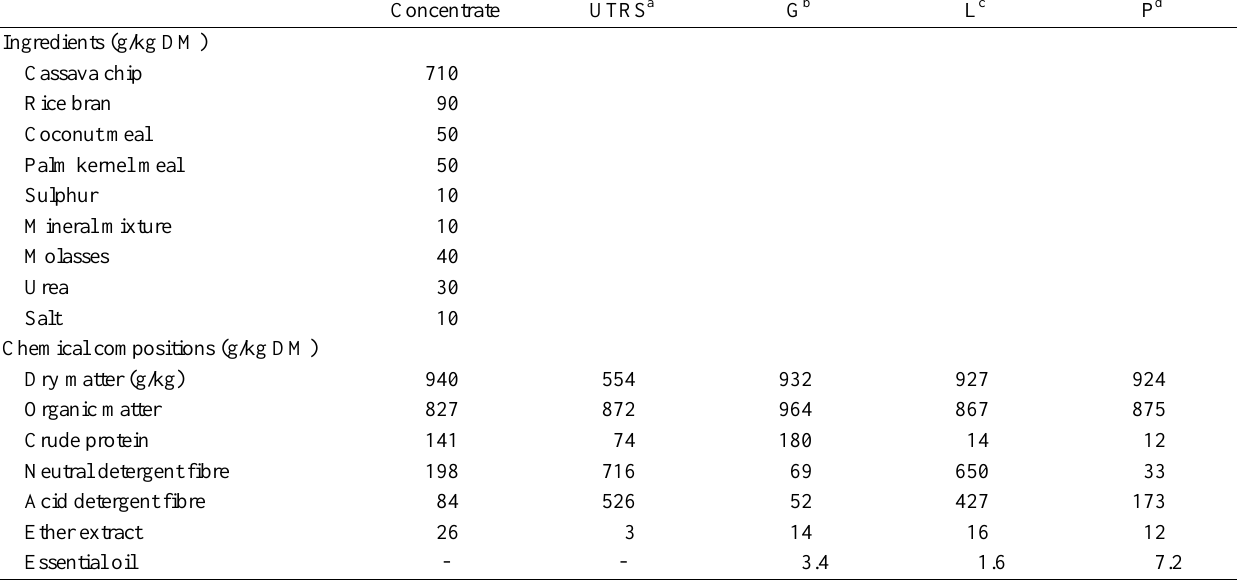
Table 1. Ingredients and chemical compositions of the concentrate, urea treated rice straw, garlic powder, peppermint powder